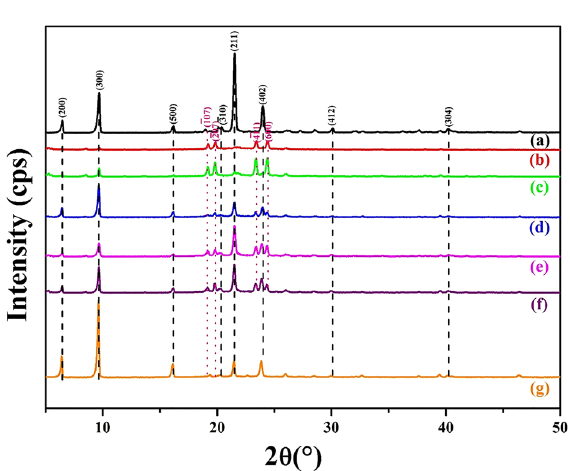
Figure 3. XRD patterns of ( a ) LA, ( b ) LAPC-1, ( c ) LAPC-2, ( d ) LAPC-3, ( e ) LAPC-4, ( f ) LAPC-5 and ( g )